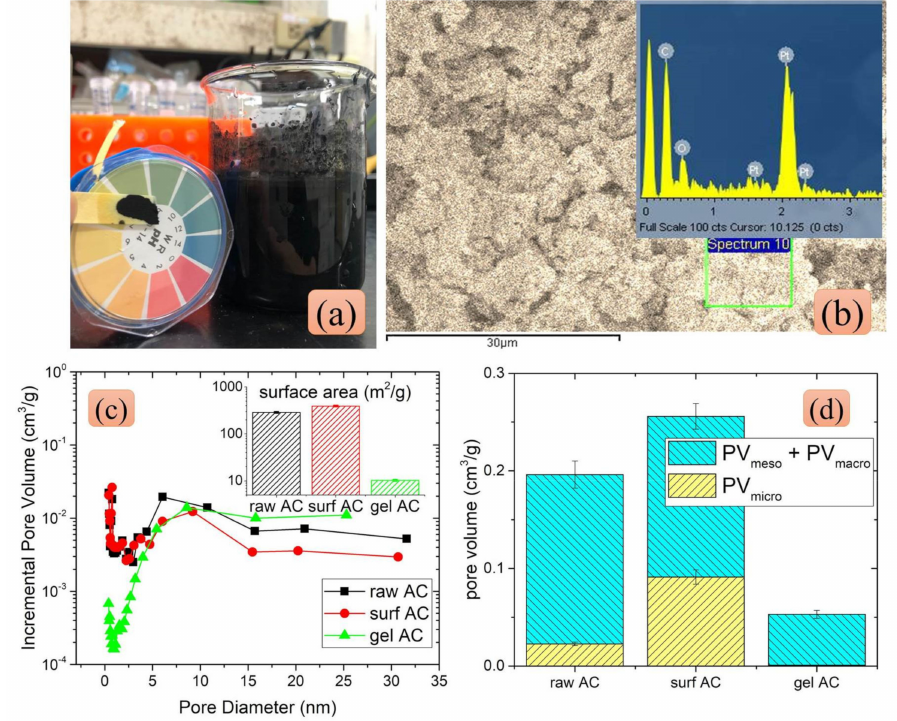
Figure 5. ( a ) Stack column plots of PV micro and PV meso + PV macro and ( b ) surface area of raw and gel-modified regenerated AC; representative ( c ) cumulative and ( d ) incremental pore volumes of the BJH desorption pore distributions of the raw, gel 1, gel 3, and gel 6